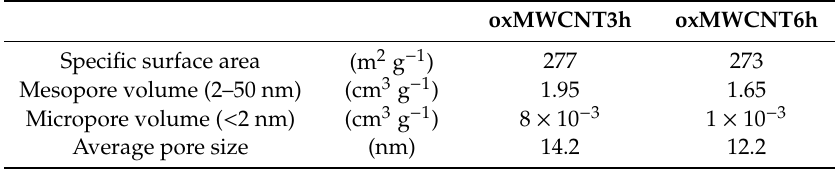
Table 3. Textural properties of oxMWCNT3h and oxMWCNT6h.